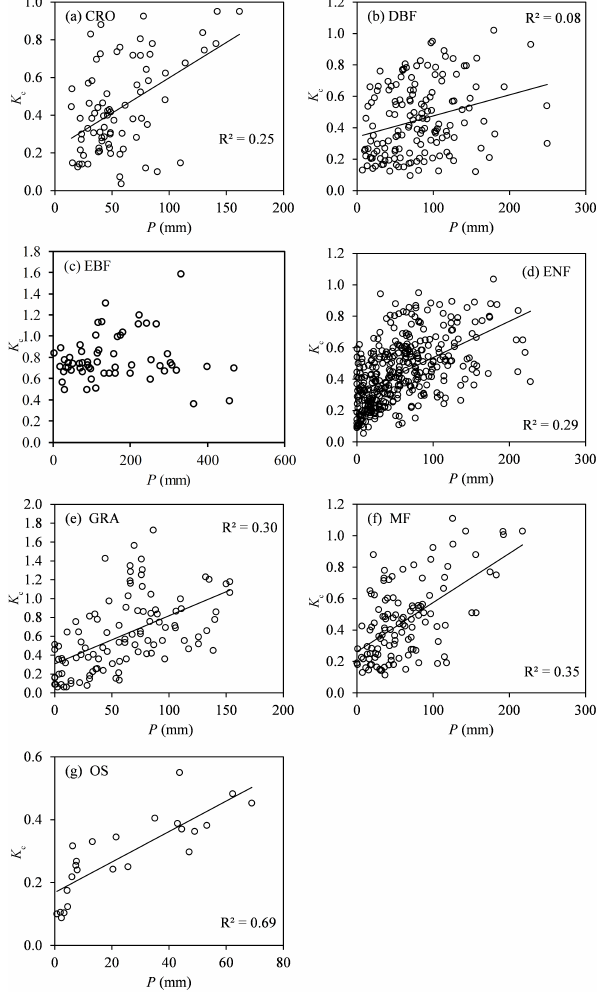
Figure 7. Relationships between the average monthly K c and leaf area index for different vegetation surfaces. Panels (a–g) stand for cropland (CRO), deciduous broad leaf forest (DBF), evergreen broad leaf forest (EBF), evergreen needle leaf forest (ENF), grass- land (GRA), mixed forest (MF), and open shrubland (OS). All the determination coefficients ( R 2 ) listed in the figure were significant ( p